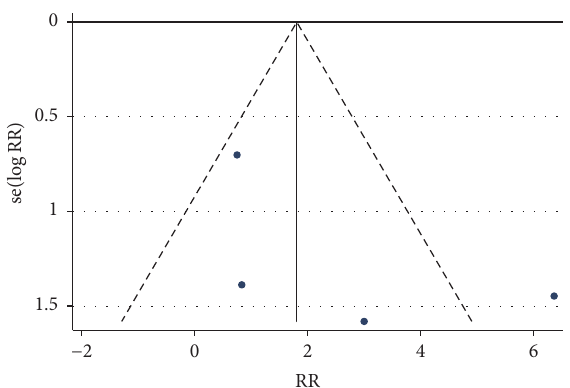
Figure 3: Assessment of publication bias using funnel plot with pseudo 95% confidence